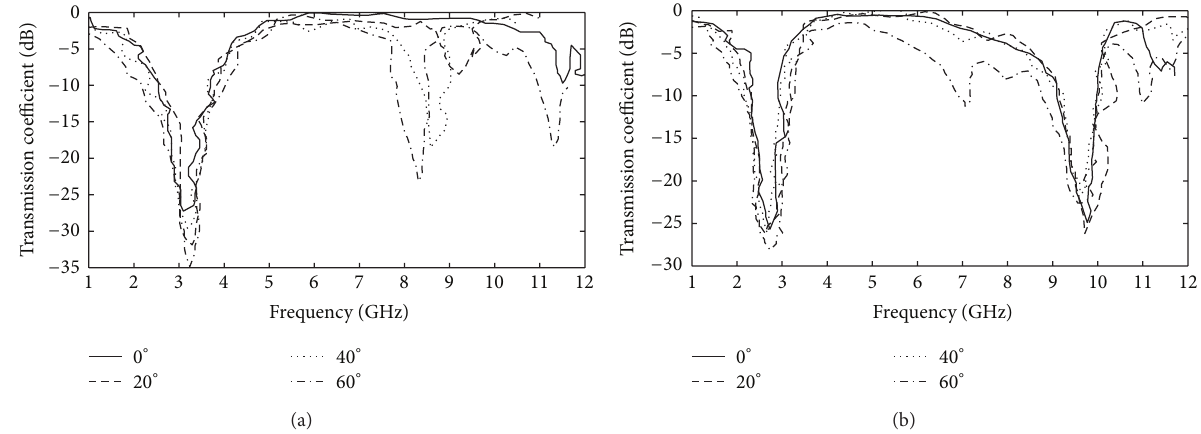
Figure 8: Measured transmission coefficient concerning the plane wave incidence angle and TE polarization for the proposed FSS structures: (a) FSS 1 and (b) FSS 2